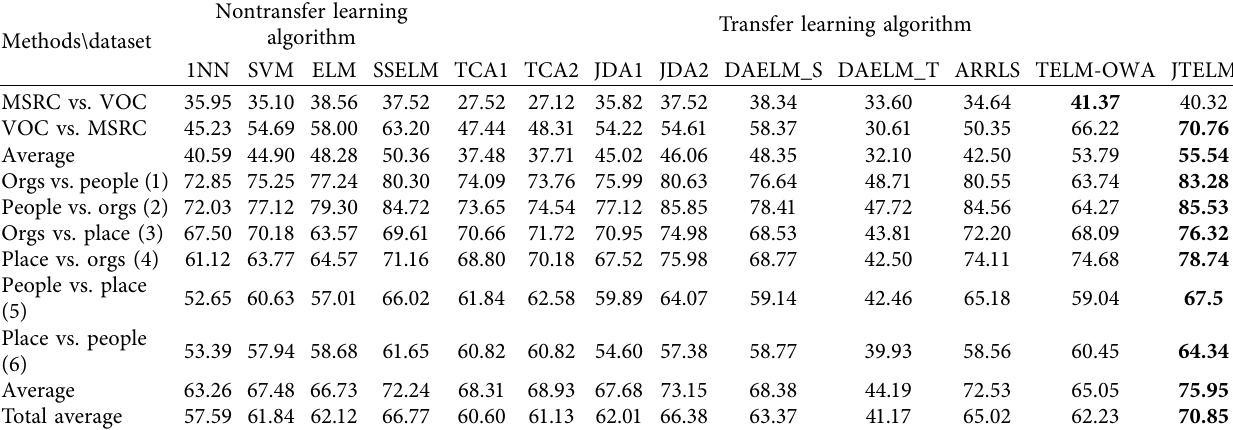
Table 3: Accuracy of diferent algorithms on MSRC +VOC2007 and Reuters-21578 datasets.